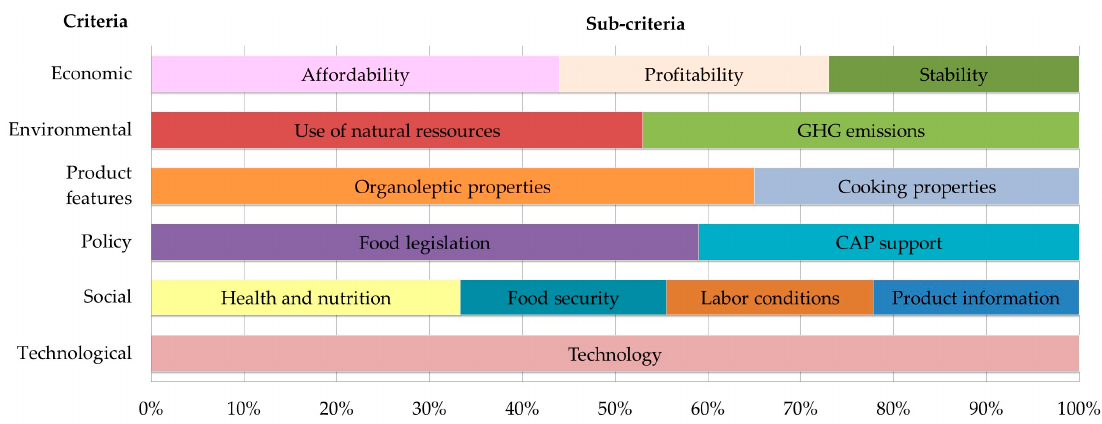
Figure5. Figure 5. Weights assigned to each sub-criterion (% of the total weight of the criteria) (all stakeholder’ views).